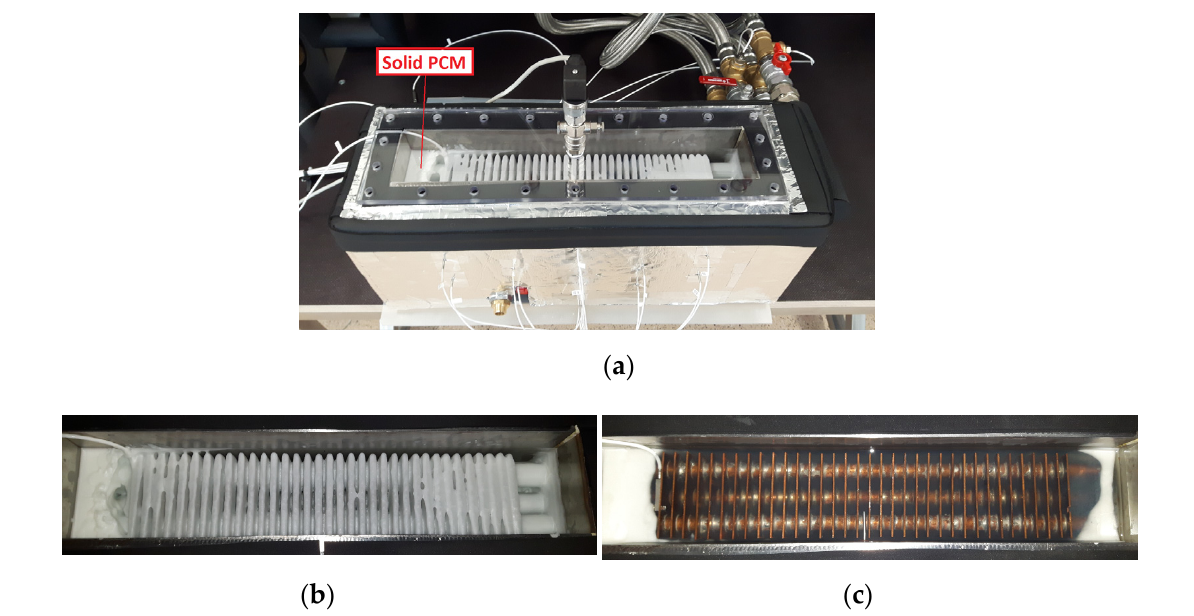
Figure 3. PCM-based TES unit with a copper heat exchanger (PCM-HX): ( a ) general view ( b ) the interior of the PCM-HX (the beginning of the melting process—solid PCM), ( c ) the interior of the PCM-HX (the end of the melting process—liquid PCM). Table 2. Properties of PCM